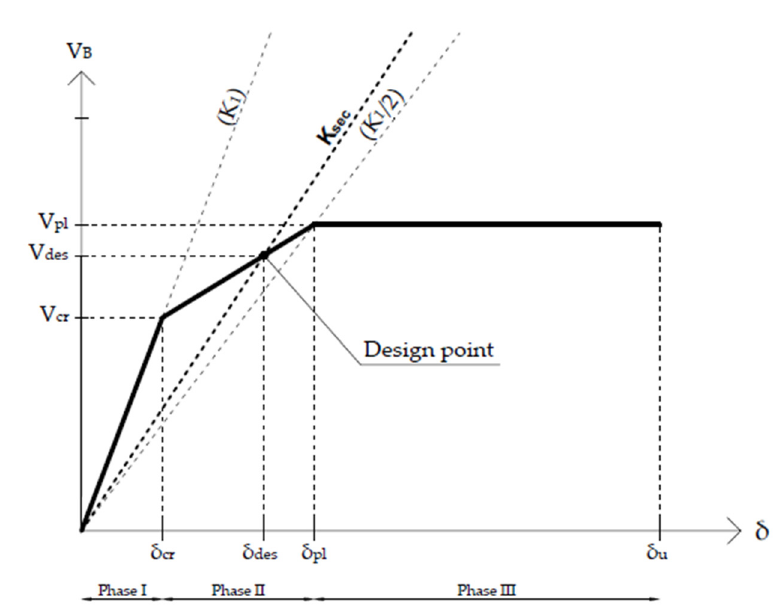
Figure 4. Definition of the secant K sec based on the Lower-bound pushover analytical curve, defined in [7].